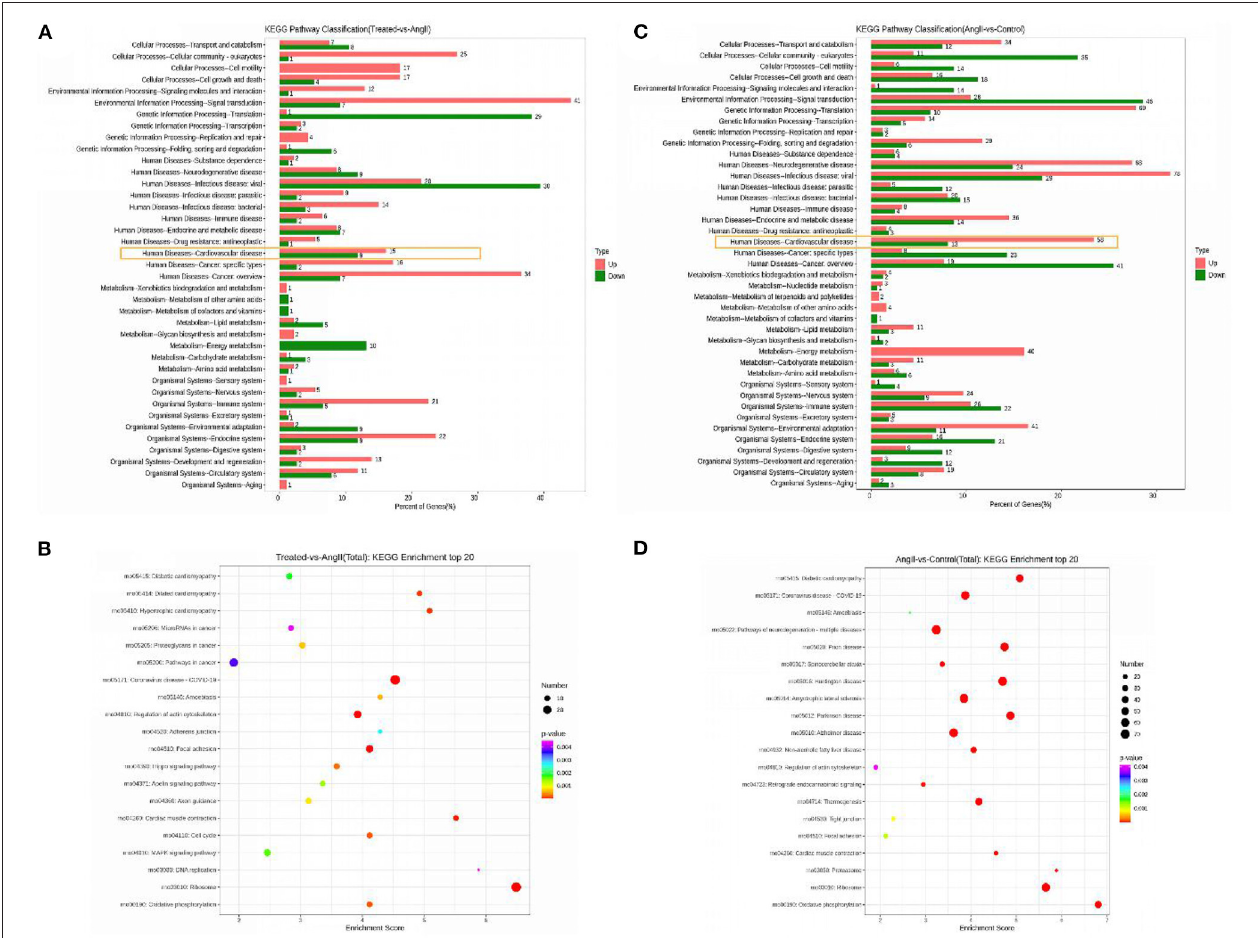
FIGURE 8 | Kyoto Encyclopedia of Genes and Genomes (KEGG) enrichment analysis for differentially expressed genes (DEGs). (A) KEGG pathway classification of DEGs in the FPQYLQYPY treated group and Ang II-treated group. (B) Bubble chart of the top 20 significantly enriched pathways for DEGs in the FPQYLQYPY treated group and Ang II-treated group. (C) KEGG pathway classification of DEGs in the Ang II-treated group and control group. (D) Bubble chart of the top 20 significantly enriched pathways for DEGs in the Ang II-treated group and control